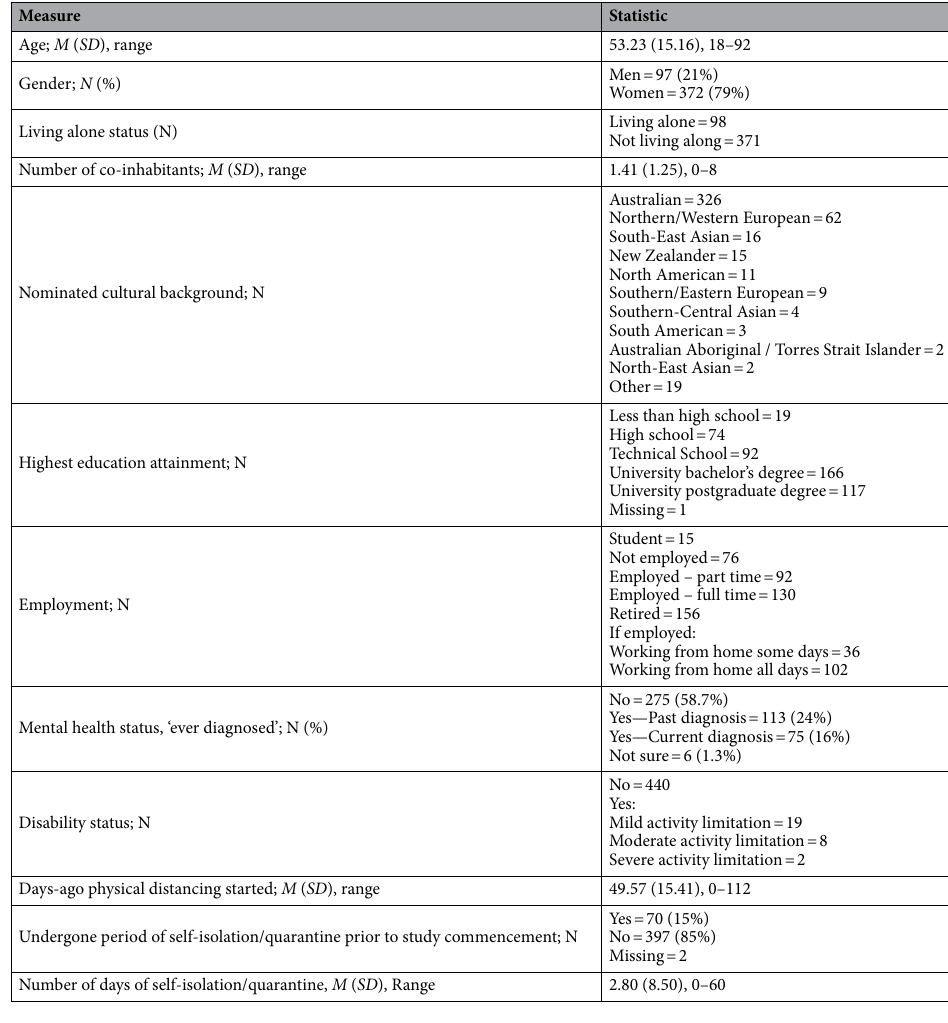
Table 1. Demographic characteristics of participants, N = 469.